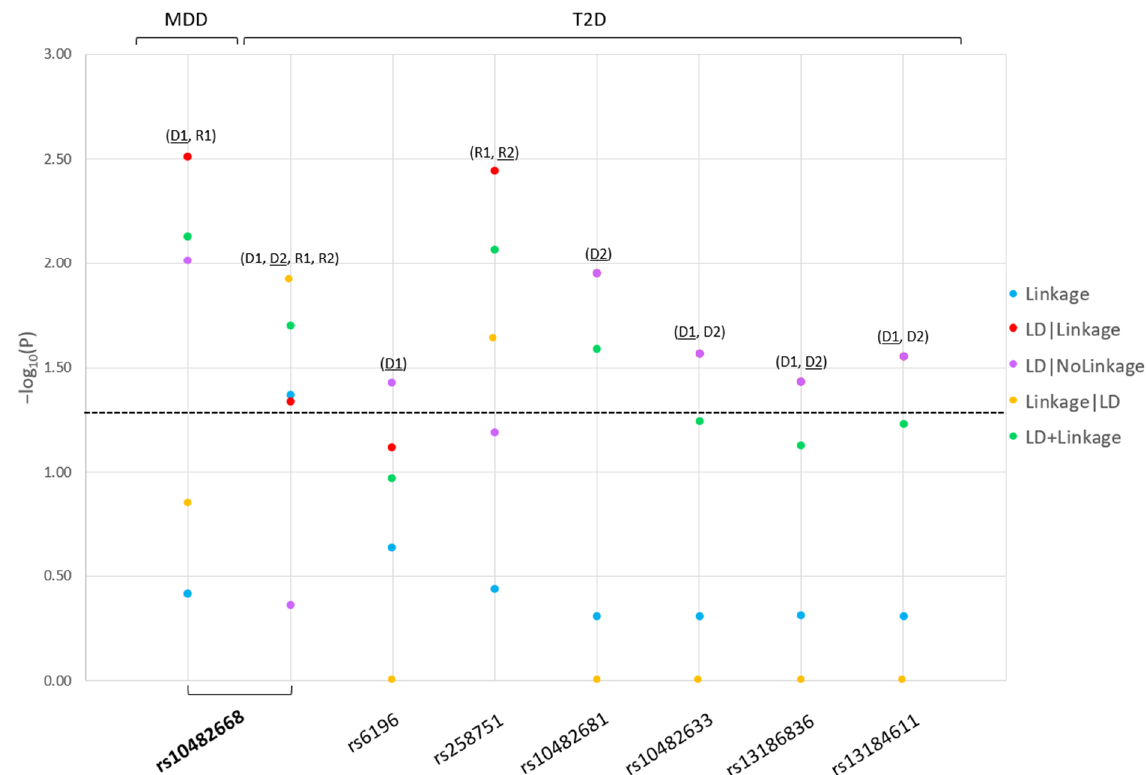
Figure 1. Major depressive disorder and type 2 diabetes NR3C1 risk single nucleotide polymor- phisms linkage and linkage disequilibrium analysis results. Legend: For each significant risk single nucleotide polymorphism (SNP) in the NR3C1 gene, we present the –log10(P) as a function of each test statistic (Linkage, Linkage Disequilibrium (LD)|Linkage, LD|NoLinkage, Linkage|LD, and LD + Linkage) and label the inheritance model: D1: dominant, complete penetrance, D2: dominant, incomplete penetrance, R1: recessive, complete penetrance, R2: recessive, incomplete penetrance. For each single nucleotide polymorphism (SNP), we present the most significant test statistics (under- lined) across the significant models. The bolded SNP is comorbid for major depressive disorder and type 2 diabetes.